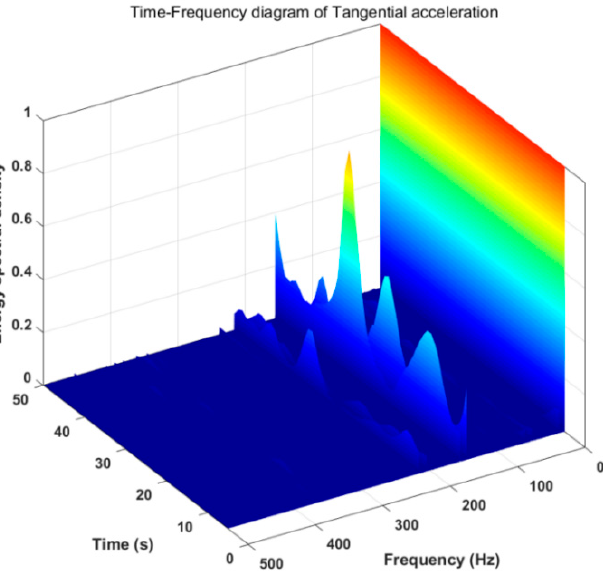
Figure 13. Time ‐ frequency diagram of tangential acceleration of stick ‐ slip vibration. Figure 13. Time-frequency diagram of tangential acceleration of stick-slip vibration.